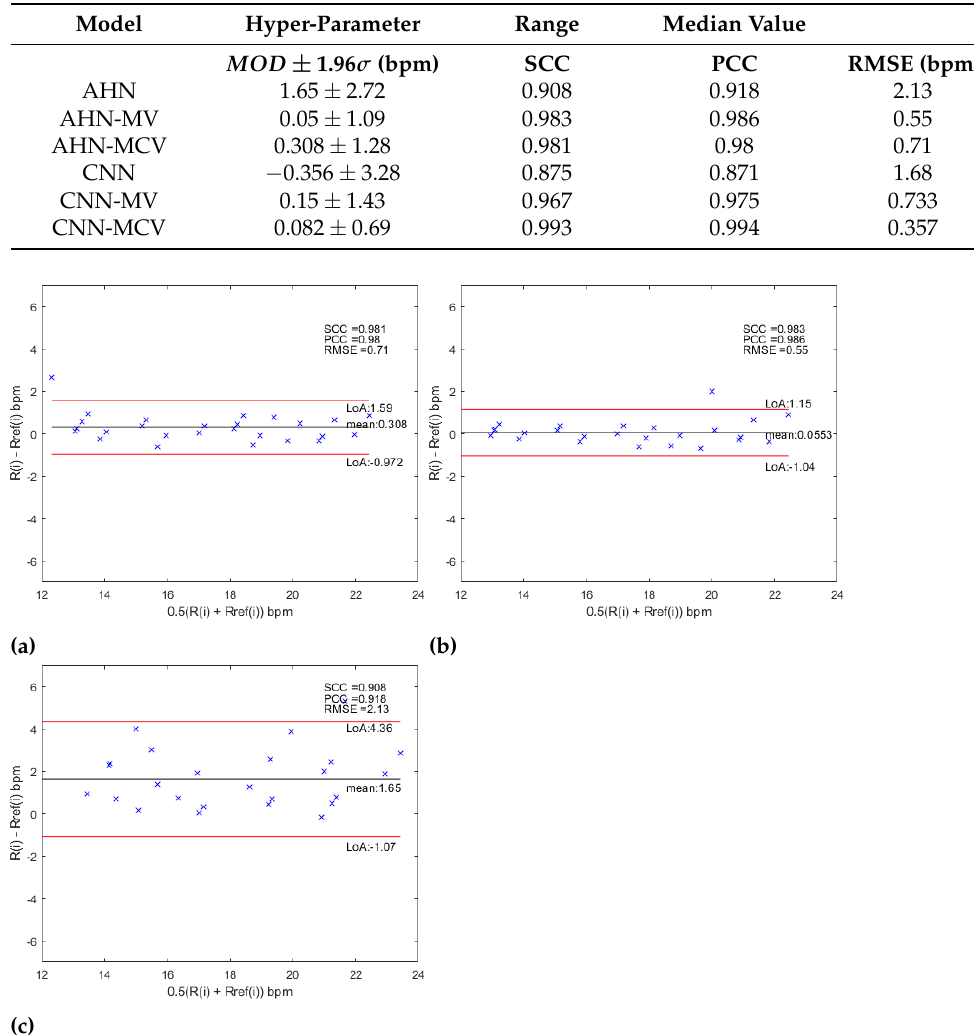
Table 9. Bland–Altman metrics, correlation metrics (SCC and PCC) and RMSE for CNN and AHN strategies.